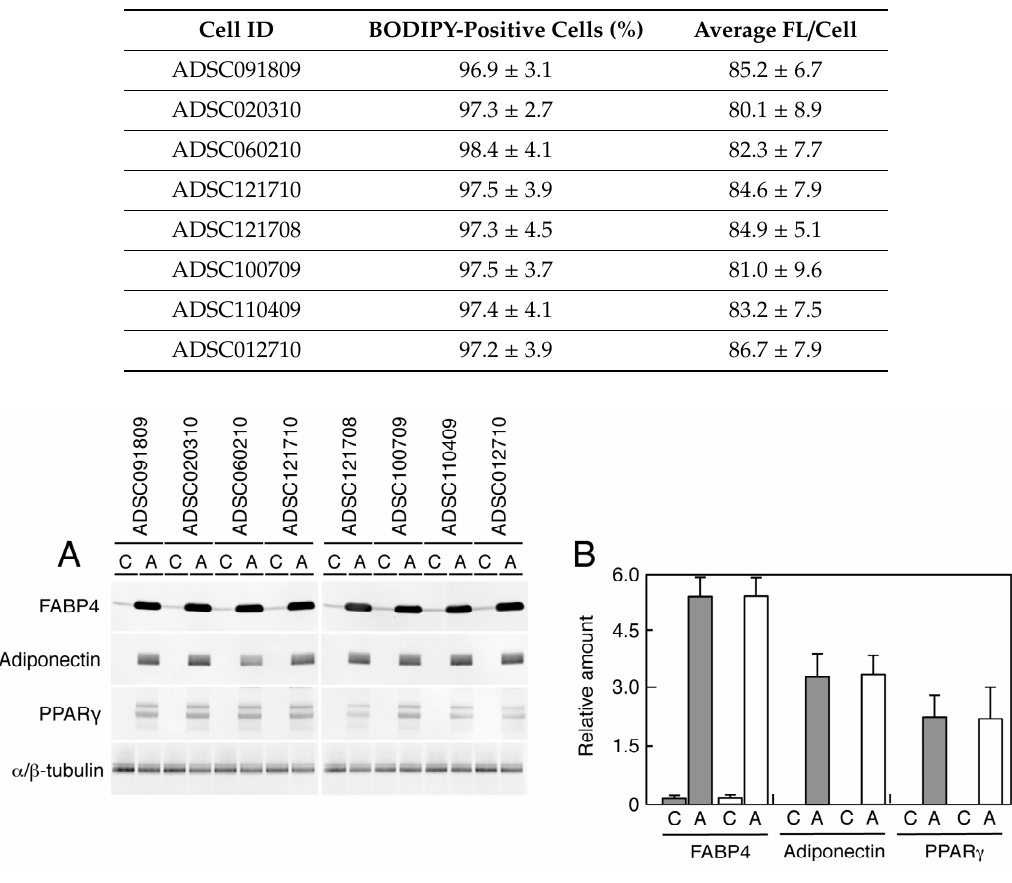
Figure 3. Western blot analysis of adipose-associated proteins. Samples (8 µg for tubulin and 16 µg for other proteins) were subjected to Western blot analysis probed with anti-FABP4, adiponectin, PPAR γ , and α / β -tubulin antibodies ( A ). Relative levels of the bands to those of α / β -tubulin were calculated and summarized in ( B ). C—cells grown in the control medium; A—cells differentiated in adipogenic medium. Gray boxes indicate the mean amount observed in the cells from HIV-uninfected patients, while white boxes indicate that observed in the cells obtained from HIV-infected patients. Bars indicate S.D.